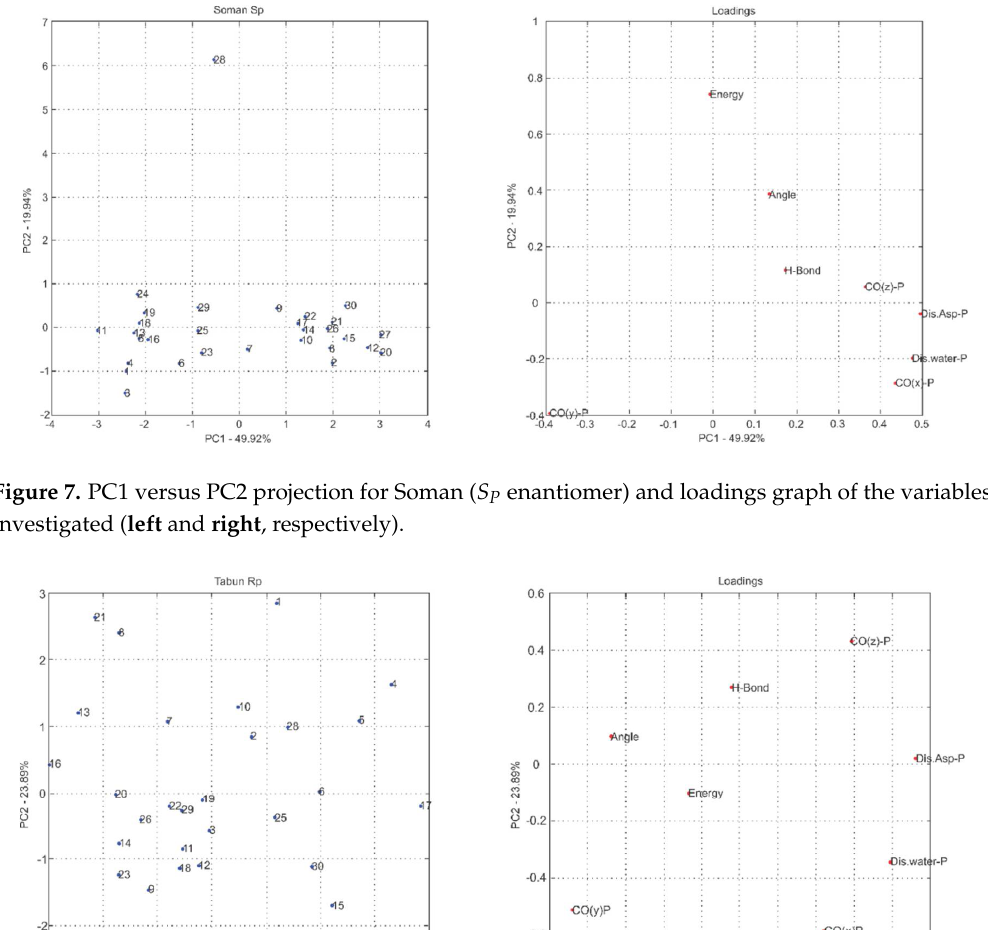
Figure 8. PC1 versus PC2 projection for Tabun ( R P enantiomer) and loadings graph of the variables investigated ( left and right , respectively).